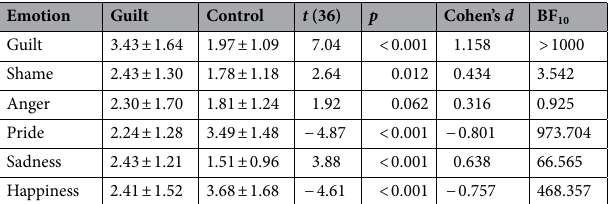
Table 1. Results (M ± SD) of the manipulation check for the face-specific guilt-induction